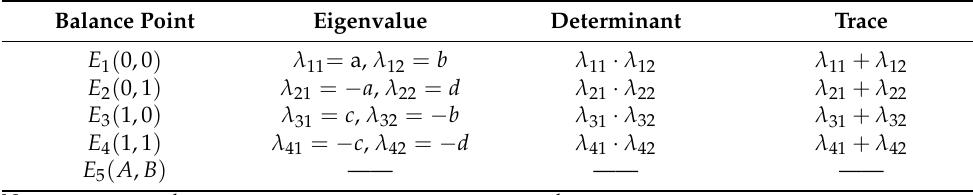
Table 3. Characteristics of local equilibrium point taking values. Balance Point Eigenvalue